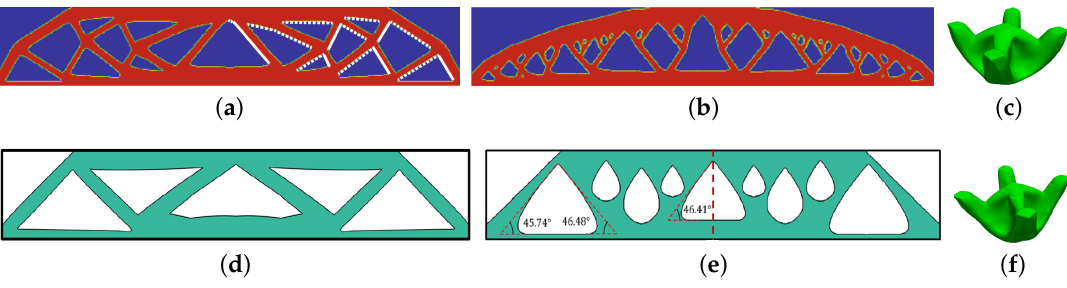
Figure 7. Comparison of TO results ( a ) without and ( b ) with overhang constraints using a simplified fabrication model [81]. TO results ( d ) without and ( e ) with overhang constraints using moving morphable components [82]. TO results ( c ) without and ( f ) with overhang constraints using convolution methodology